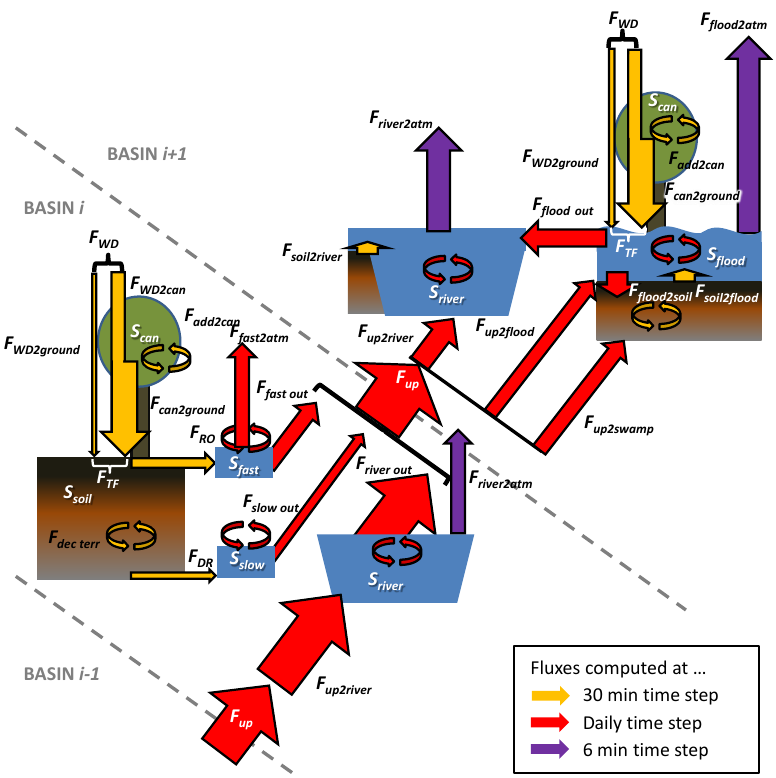
Figure 3. Simulated flows of water and C along the vegetation–soil–water continuum. For reasons of simplicity, the fluxes ( F ) and storages ( S ) are characterized by subscripts indicating path or environmental compartment only (see Table A1). Basin i − 1 is the basin upstream of basin i , basin i + 1 is the basin downstream of basin i . In this hypothetical example, swamps and floodplains are only present in basin i + 1. The depiction of water and soil-river C fluxes in basins i + 1 and i − 1 were omitted for reasons of readability. Straight arrows represent water and C fluxes between the canopy ( S can ), soil ( S soil ), fast ( S fast ), slow ( S slow ), river ( S river ) and flood ( S flood ) reservoirs. Circular arrows represent carbon transformations within the reservoirs. See text for further